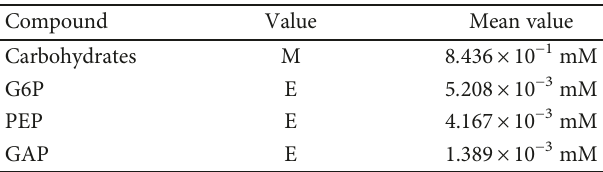
Table 5: Experimental measures (M) and estimated (E) values obtained from [4], for an autotrophic microalgae metabolic network [4]. Carbon quotas of the di ff erent compounds are considered within a period of 24 hours. Light intensity values are on an interval from 0 to 1400uE · m − 2 · s − 1 . Two di ff erent magnitudes of concentration can be distinguished among these compounds.